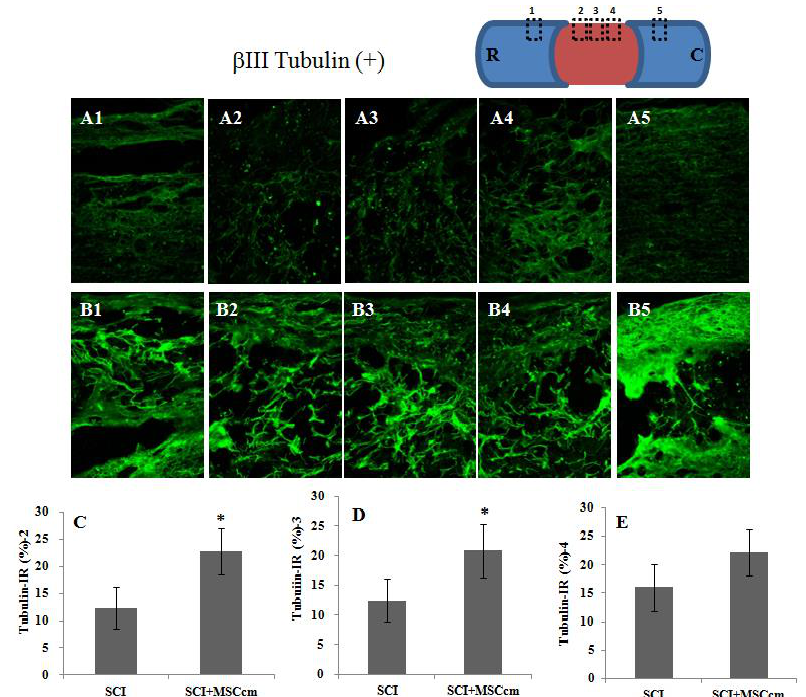
Figure 5. Tubulin-immunoreactive nerve fibers in the thoracic spinal cords of SCI rats at 6 weeks after injury. ( A ) Representative images of longitudinal spinal cord sections in SCI rat. ( B ) Representative images of spinal cord sections in MSCcm-treated SCI rat. ( C – E ) Quantification of tubulin-positive axons in area 1, 2 and 3, respectively, of spinal cord sections shown in A and B. Note the significant increase of tubulin positive nerve fibers in MSCcm-treated groups at 6 weeks postinjury. MSCcm was administered to SCI rats through tail vein injection after spinal cord contusion. After 6 weeks, immunofluorescence positive area of beta III tubulin was detected in a longitudinal section at the epicenter of the spinal cord. The results are reported as mean ± SEM. Statistical significance was evaluated using one-way ANOVA and Bonferroni’s t -test. * p < 0.05.